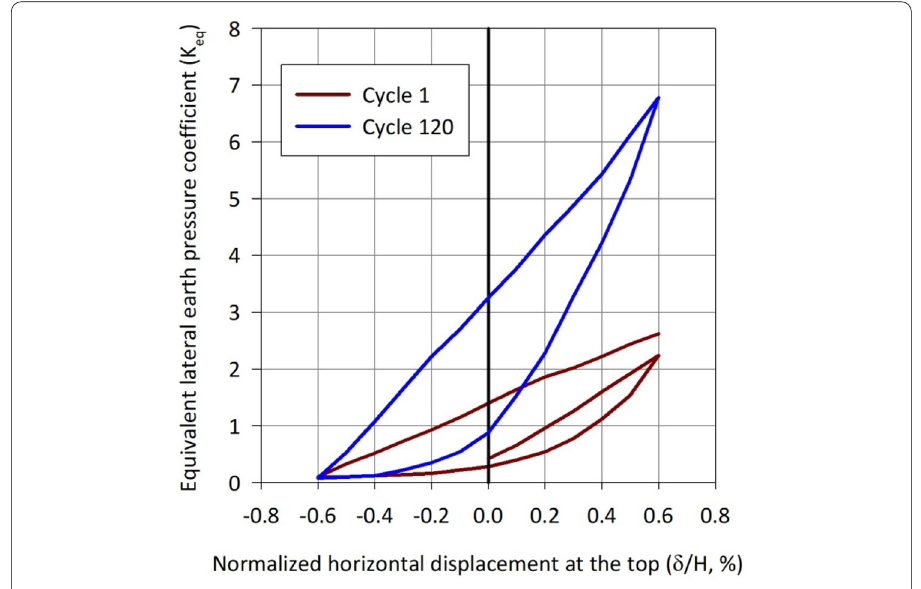
Fig. 14 Variation of the equivalent lateral earth pressure coefficient (K) during cycles 1 and 120 (Test 1)